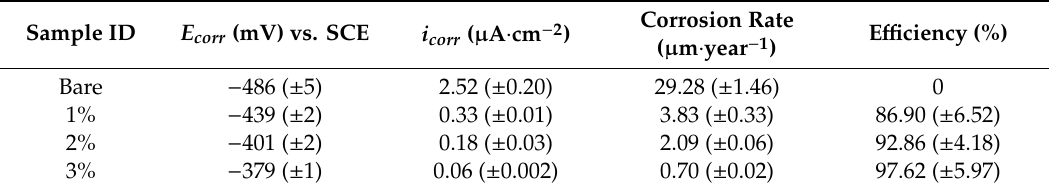
Table 1. Electrochemical parameters of steel rebars obtained from fitting of potentiodynamic plots